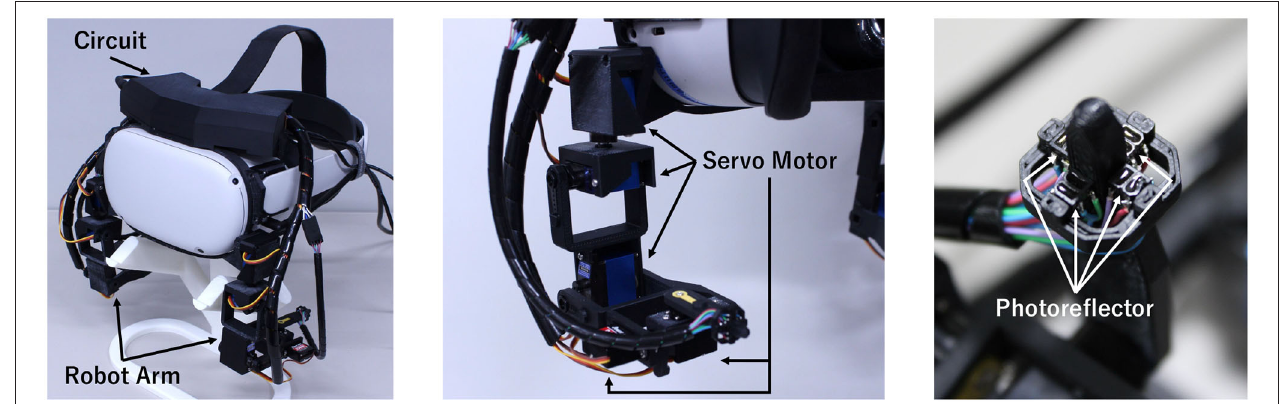
FIGURE 4 | Haptic stimulation device. (Left) Device overview. (Center) Robot arm. (Right) Robot arm tip.